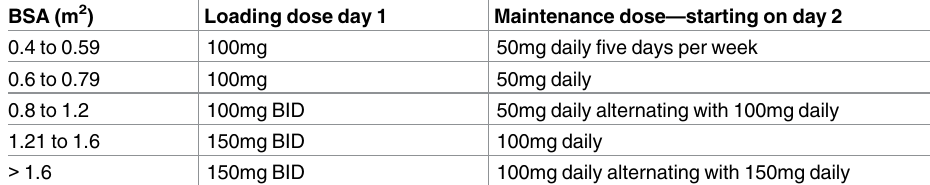
Table 3. Perifosine dose level 3 (~75 mg/m 2 /day).